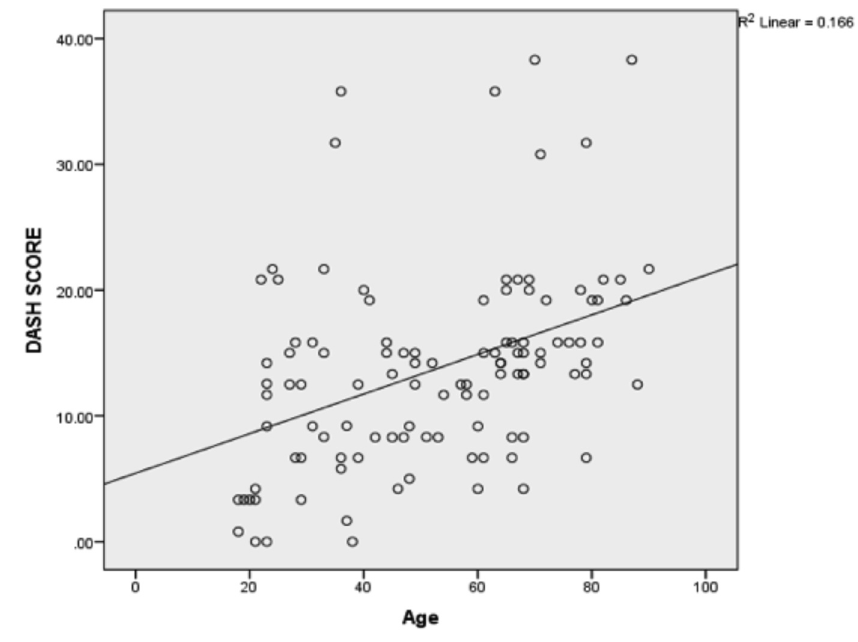
Shows the correlation between age and DASH Score. It shows Pearson coefficient = 0.407, r 2 = 0.166. There is weak positive Fig. 2: correlation between DASH score and age of patients.